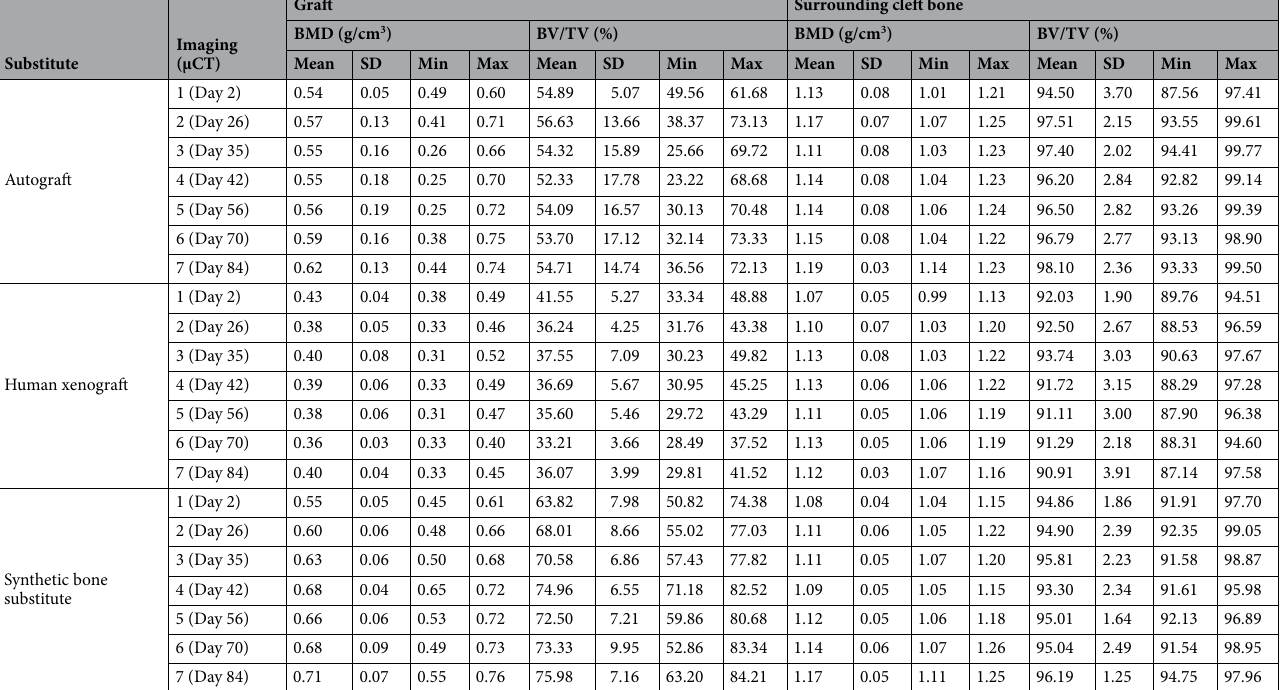
Table 1. Mean, minimum and maximum values with standard deviation (SD) of bone mineral density (BMD) and bone volume fraction (BV/TV) in three different grafting materials and the corresponding surrounding clef bone in rats over an investigation period of 84